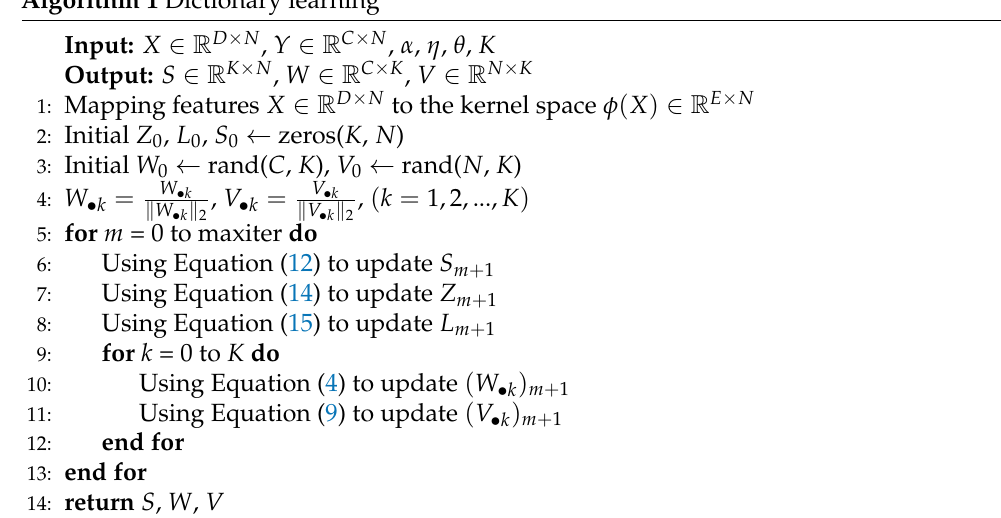
Algorithm 1 Dictionary